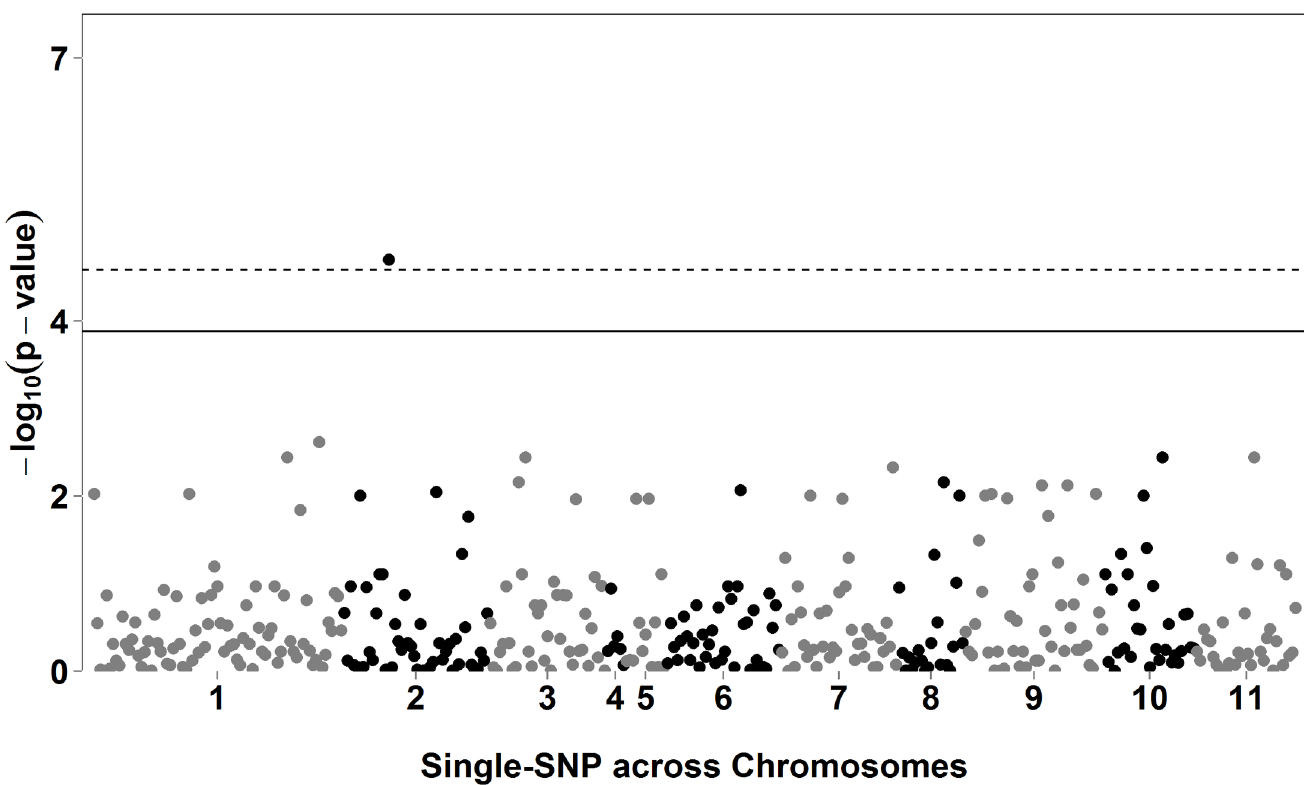
Fig 1. Manhattan plot for days to first flower (DFF) using quantile regression (QR) for quantile ( τ ) 0.1. The solid and dashed lines show the Bonferroni-adjusted thresholds of 3.88 and 4.58 for alpha equals to 5% and 1%, respectively.